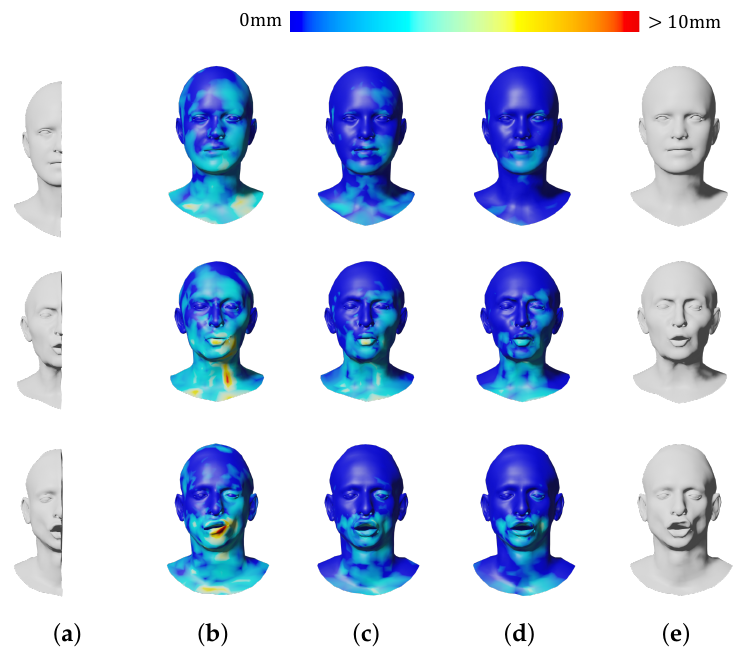
Figure 9. Qualitative comparison of shape completion. ( a ) Input; ( b ) CoMA; ( c ) SpiralNet++; ( d ) Ours; ( e ) Ground